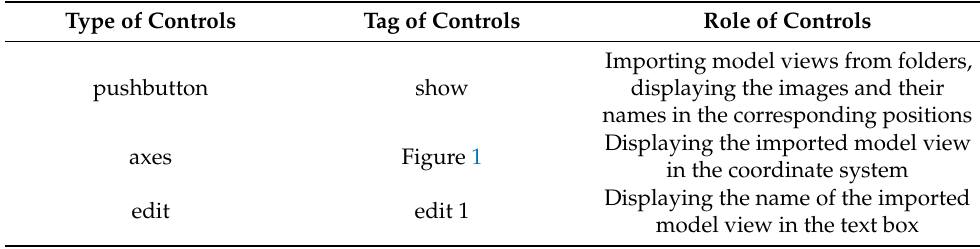
Figure 10. Initial interface and sample demonstration of Module 1. Table 1. Types, labels, and roles of controls used in the Module 1 interface.